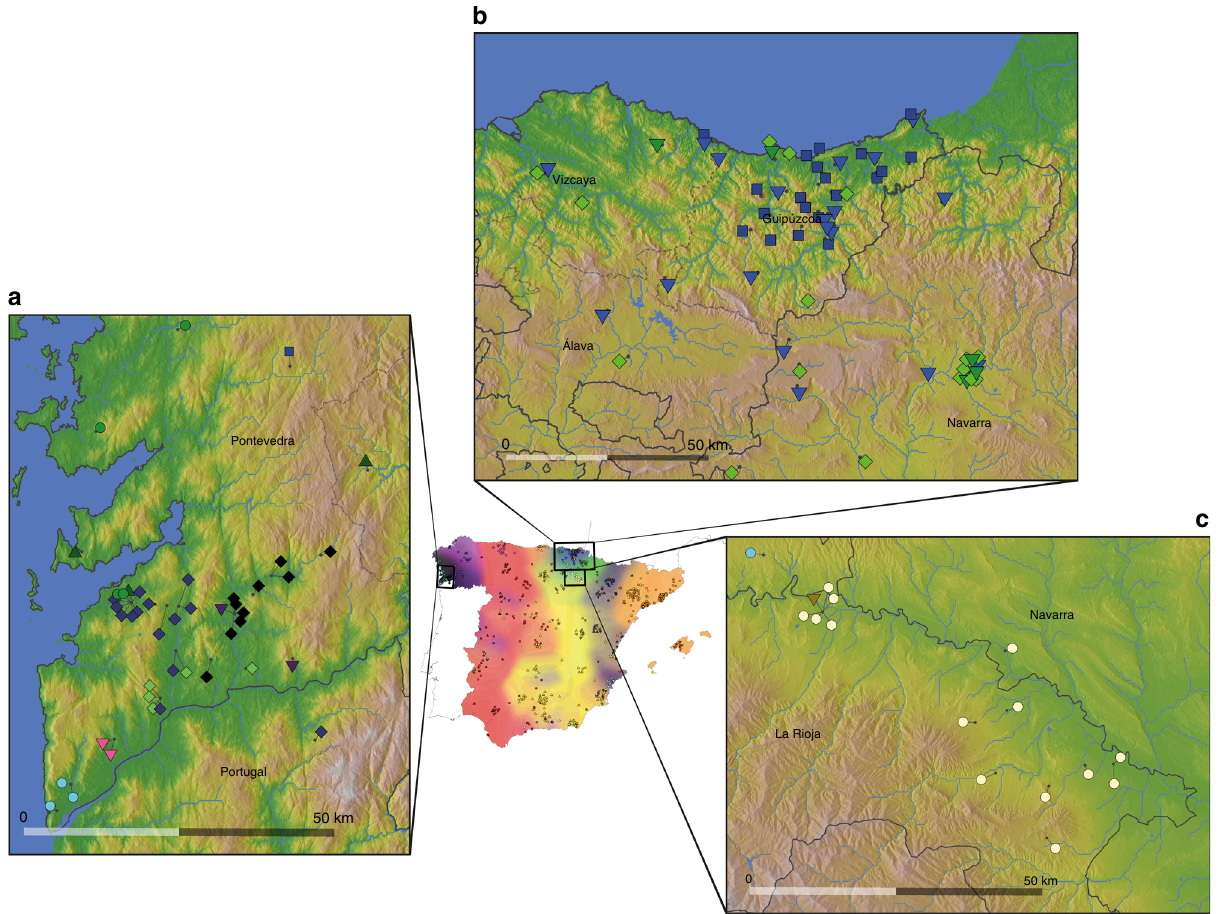
Fig. 3 Ultra- fi ne-scale genetic structure within Spain. Points representing individuals are placed on each of the magni fi ed maps and coloured as described in Fig. 1, with short dark lines pointing to their precise locations (the average birthplace of their grandparents). The three magni fi ed maps show local elevation, rivers, and water bodies, as well as borders of autonomous communities (solid black lines) and provinces (dashed lines and text). a Locations of individuals (44) within the genetic clusters centred in Galicia. Note that we show this region at a higher level of the tree (14) as the lower level yields clusters with fewer than three individuals with fi ne-scale geographic location data. b Locations of individuals (60) within the clusters centred in the Basque-speaking regions of País Vasco (Basque Country) and Navarra. For visual clarity we only show the individuals that are within the clade coloured blue and green in Fig. 1. This clade makes up the majority of all individuals located in this region, and a majority of this clade is located in this region (60 of 64 with geographic data). c Locations of individuals (16) who almost all comprise a single cluster exclusive to a ~50-km-wide region along the banks of the